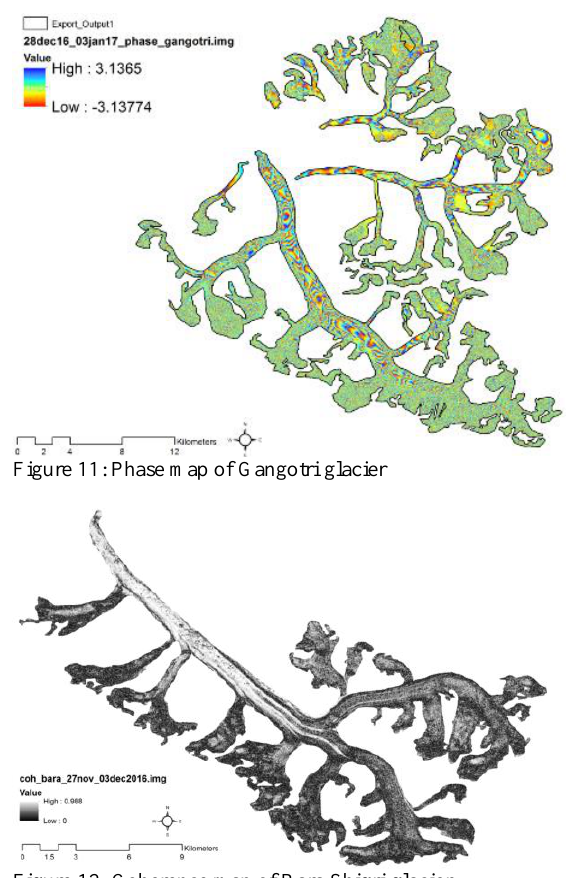
Figure 12: Coherence map of Bara Shigri